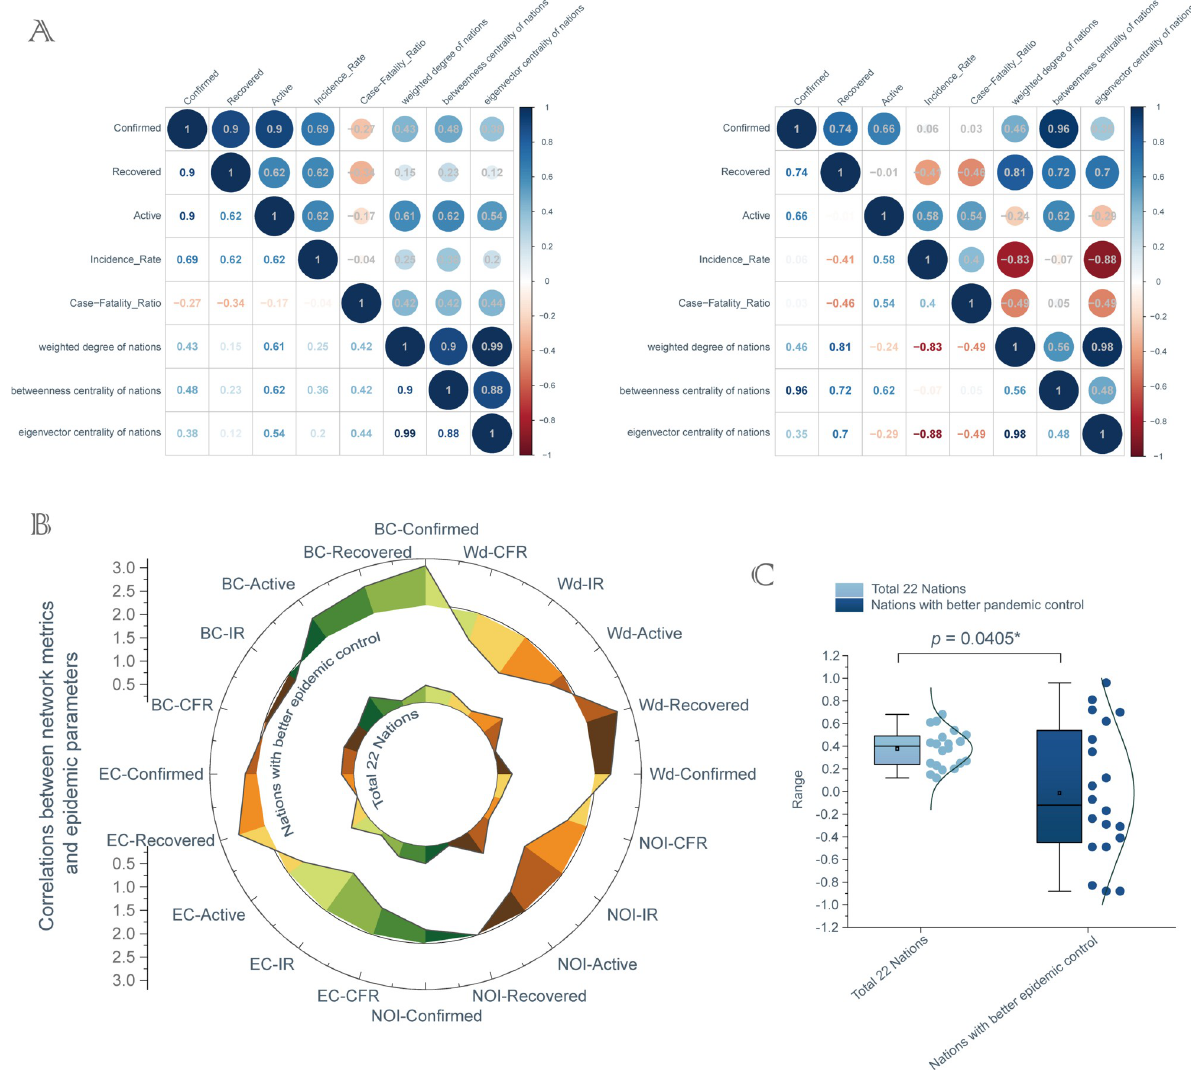
Fig 3. The imbalance between international collaboration and COVID-19 control. (A) Matrix analysis of the correlation between network metrics and pandemic parameters. left panel: 22 selected nations, right panel: nations only with good pandemic control. (B) Circos plot to show the correlation between network metrics and pandemic parameters for both cohorts, respectively. (C) Results of two-tailed paired t -test are � p < 0.05, t = 2.199, n = 20. Wd: weighted degree, BC: betweenness centrality, EC: eigenvector centrality, NOI: number of institutions (top 1000), IR: incidence- rate, CFR: case-fatality-ratio; Wd-Confirmed: the correlation between weighted degree and confirmed cases, and so on.